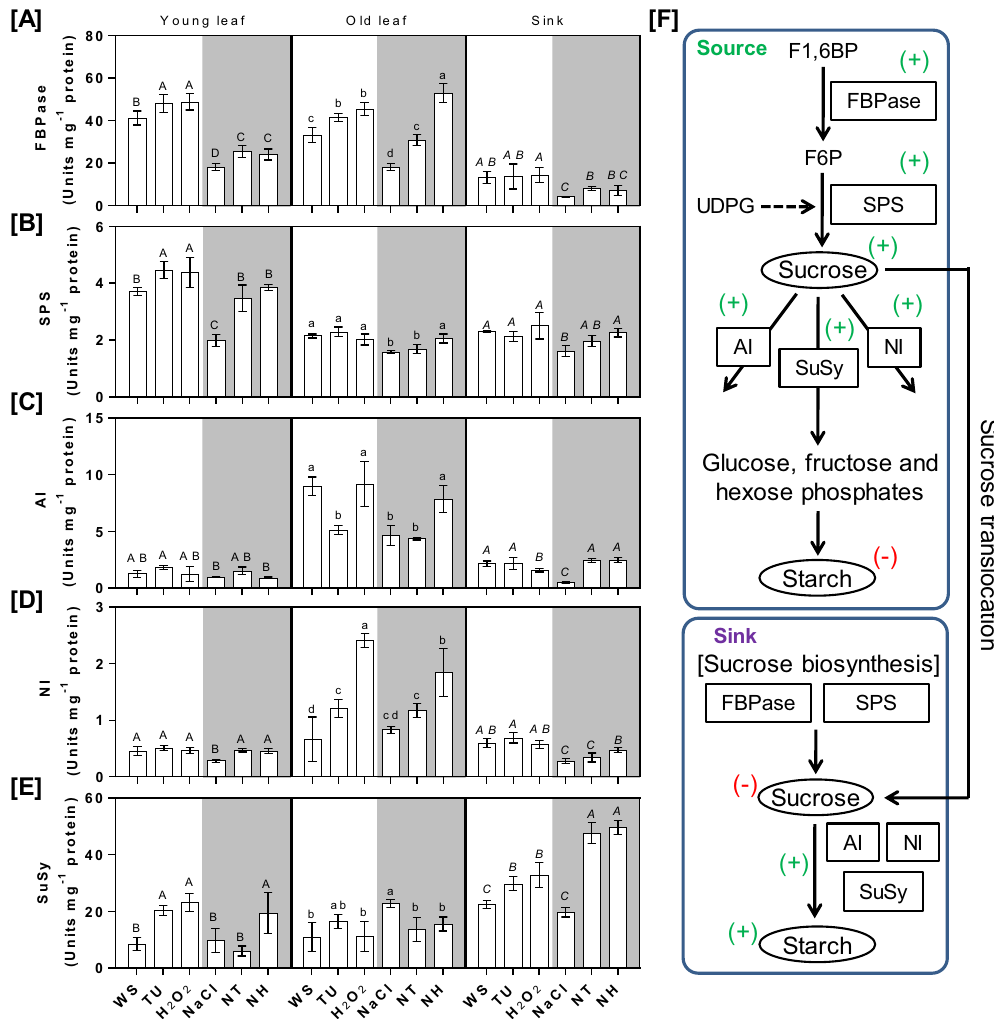
Figure 6. Quantification of enzymes and metabolites regulating source-sink equilibrium. Pot-grown rice plants were given different treatments including WS (DW + 0.01% Tween-20), TU (6.5 mM TU + 0.01% Tween-20) and H 2 O 2 (10 mM H 2 O 2 + 0.01% Tween-20), NaCl (22 g NaCl per pot). NT and NH denote combined treatment of NaCl + TU and NaCl + H 2 O 2 treatments, respectively. A total of three foliar applications were given at vegetative, early anthesis and grain filling stages that corresponded to 40, 55 and 72 days post-transplantation, respectively. At 5th day after 3rd foliar spray, flag leaves were harvested and activities of various enzymes including FBPase (Fructose 1,6 bis-phosphatase; A ); SPS (Sucrose phosphate synthetase; B ); AI (Acid soluble invertase; C ); NI (Neutral invertase; D ) and SuSy (Sucrose synthase; E ) were measured. All values represent mean of triplicates ± SD. Different letters indicate significantly different values (DMRT, p ≤ 0.05 ) . The right-hand panel represent the overview of sucrose biosynthesis/breakdown pathway operated in source and sink organs ( F ). The rectangles and ovals represent the enzymes and metabolites, respectively, quantified in the present study. The positive (+) and negative (−) labels denotes the role of a particular enzymes/metabolites for increasing and decreasing source/sink strength,